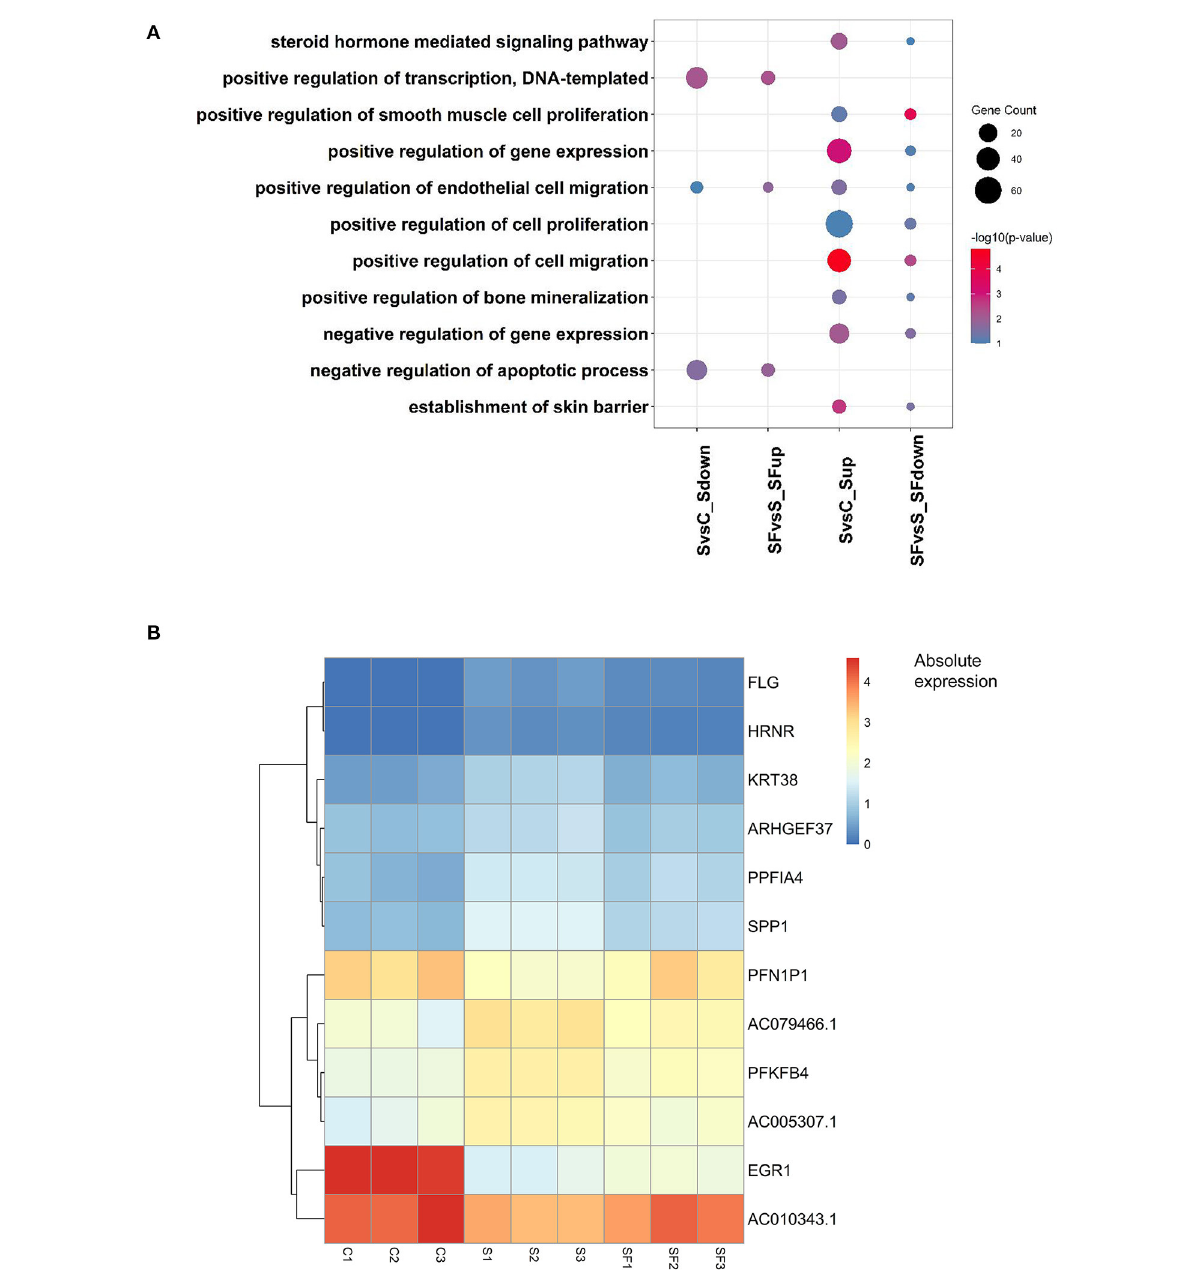
FIGURE4 Functions and genes of genes rescued by fullerenol treatment. (A) Common GO terms of DEGs induced by H 2 O 2 and fullerenol. (B) Heatmap plot of the expression of hub genes affected by H 2 O 2 and fullerenol. S, H 2 O 2 group; C, Ctrl group; SF, Fullerenol group.